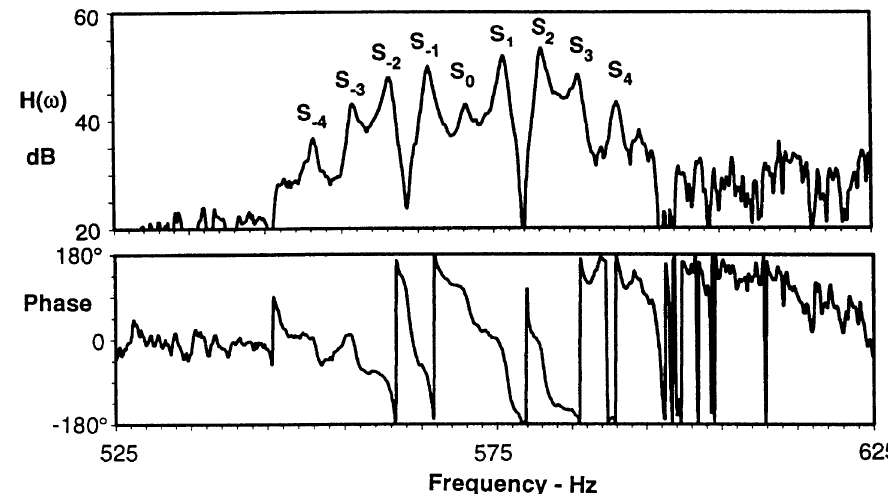
Fig. 2. Apparent Frequency Response Function of a structure with impact excitation and a CSLDV for response